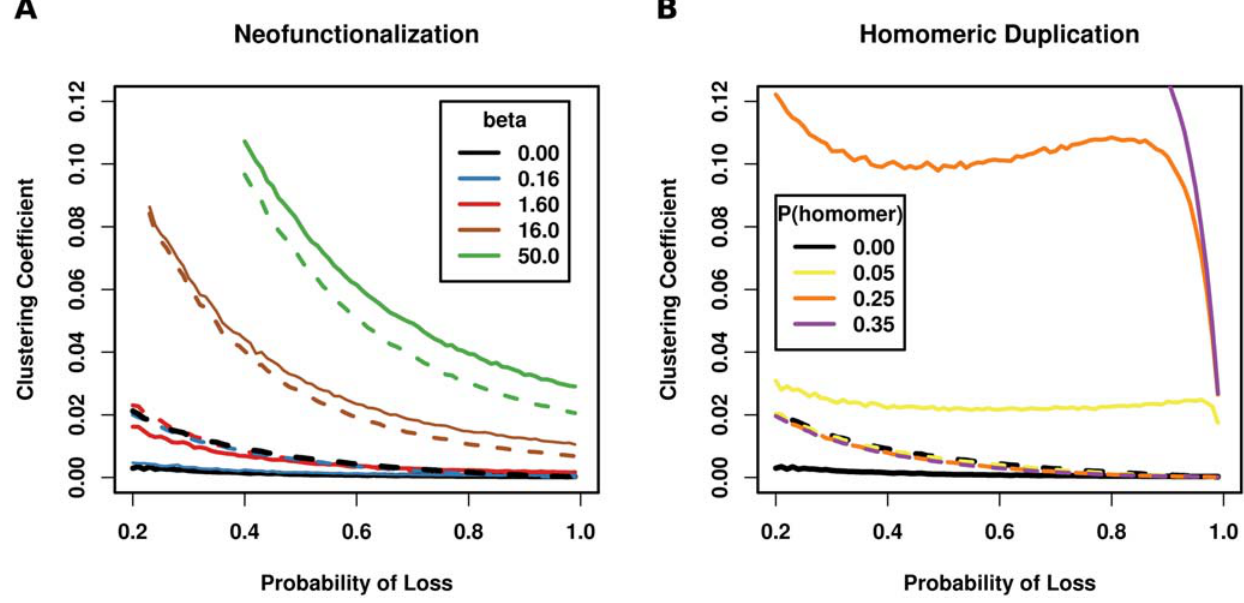
Figure 9. The clustering coefficient of networks featuring simple duplication, neofunctionalization, subfunctionalization, and homomeric duplication. Each plot shows the clustering coefficient for different probabilities of a gene duplicate losing a redundant interaction (i.e., different levels of subfunctionalization). Lines are grouped into pairs by color. A solid line is a model with a specific parameter, and a dashed line of the same color is the model’s random equivalent (see Methods). The black line pairs represent simple duplication and subfunctionalization (i.e., no neofunctionalization or homomeric duplication) and are therefore identical in both plots. (A) The Sole´ et al. model which includes neofunctionalization [7]. (B) Homomeric duplication as found in the Va´zquez et al. model [32].